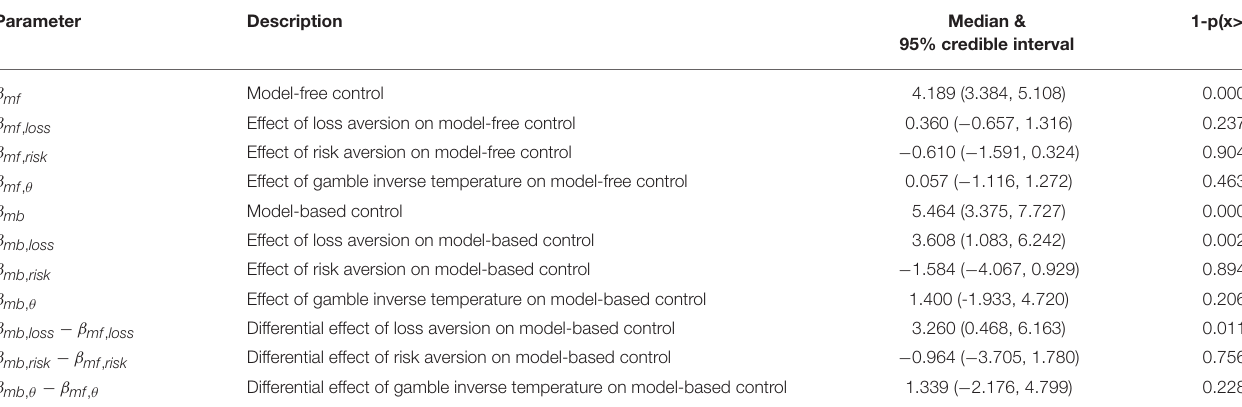
TABLE 2 | Group level estimates of model-based and model-free control in the two-step task, and the effects of the gambling task variables. Parameter